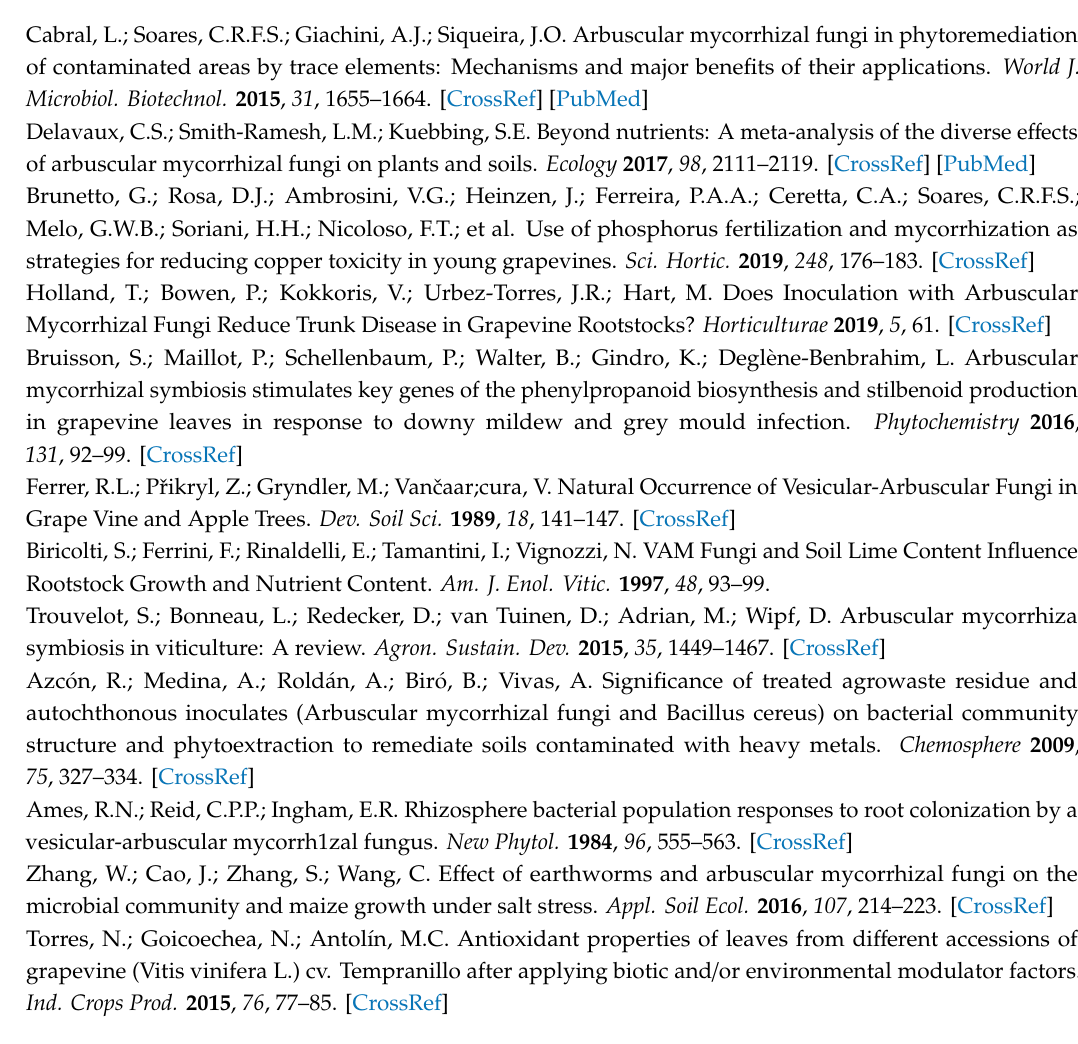
field cultivation.